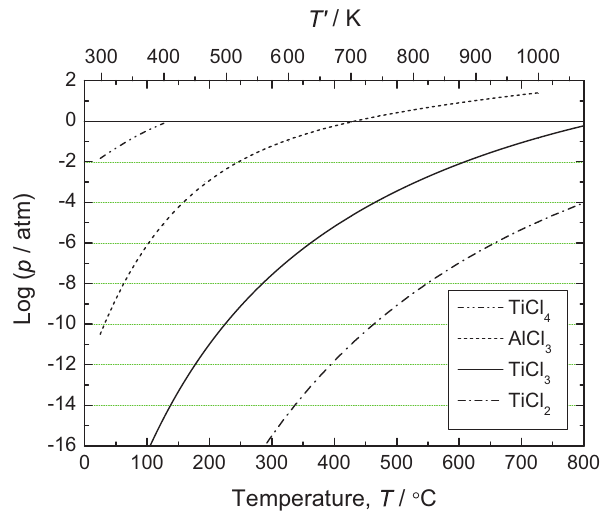
Figure 1. Equilibrium vapor pressures of chlorides on pure condensed chlorides of aluminum and titanium.